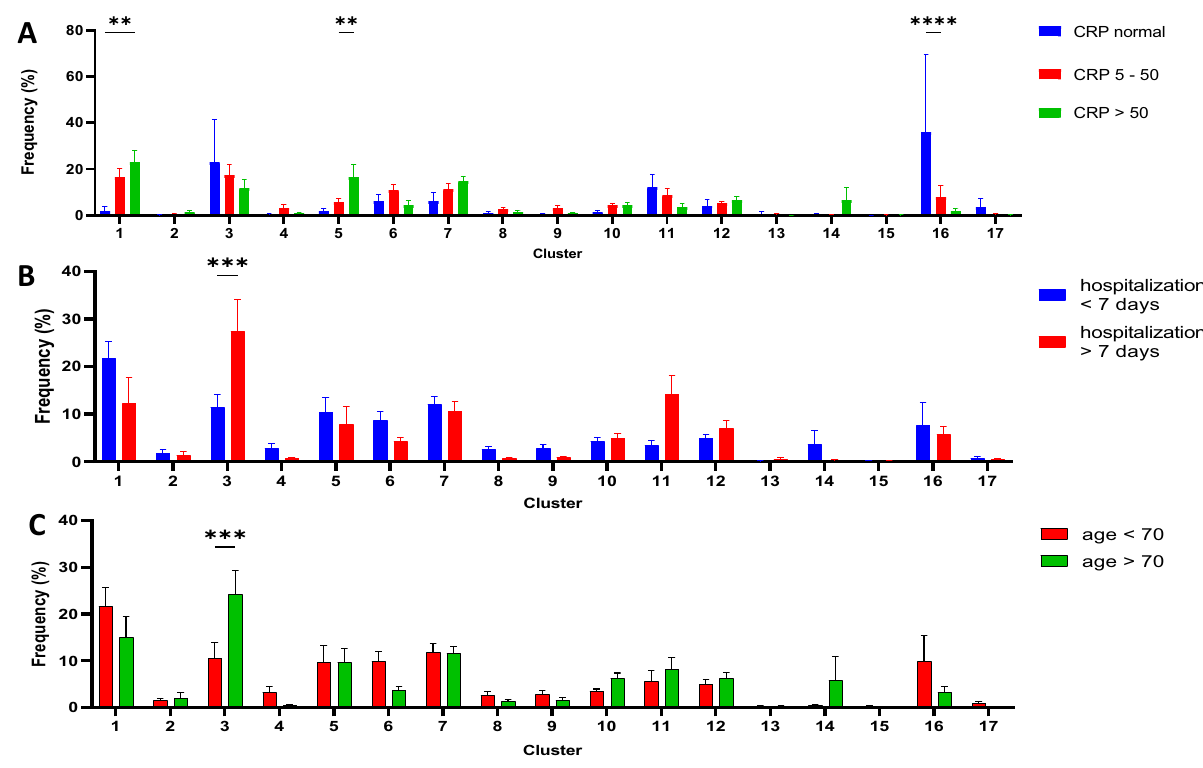
Figure 8. Comparison of Phenograph ‐ derived cluster pattern of neutrophils in ( A ) patients with normal level of CRP, CRP between 5 and 50 mg/L and CRP over 50 ; in ( B ) patients hospitalized shorter than 7 and longer than 7 days; in ( C ) patients younger than 70 year and older than 70 years. Older patients and those with longer hospitalization time had significantly higher percentage of neutrophils within cluster 3 that represents neutrophils with high expression of “don’t eat me” and activation markers such as CD11b and